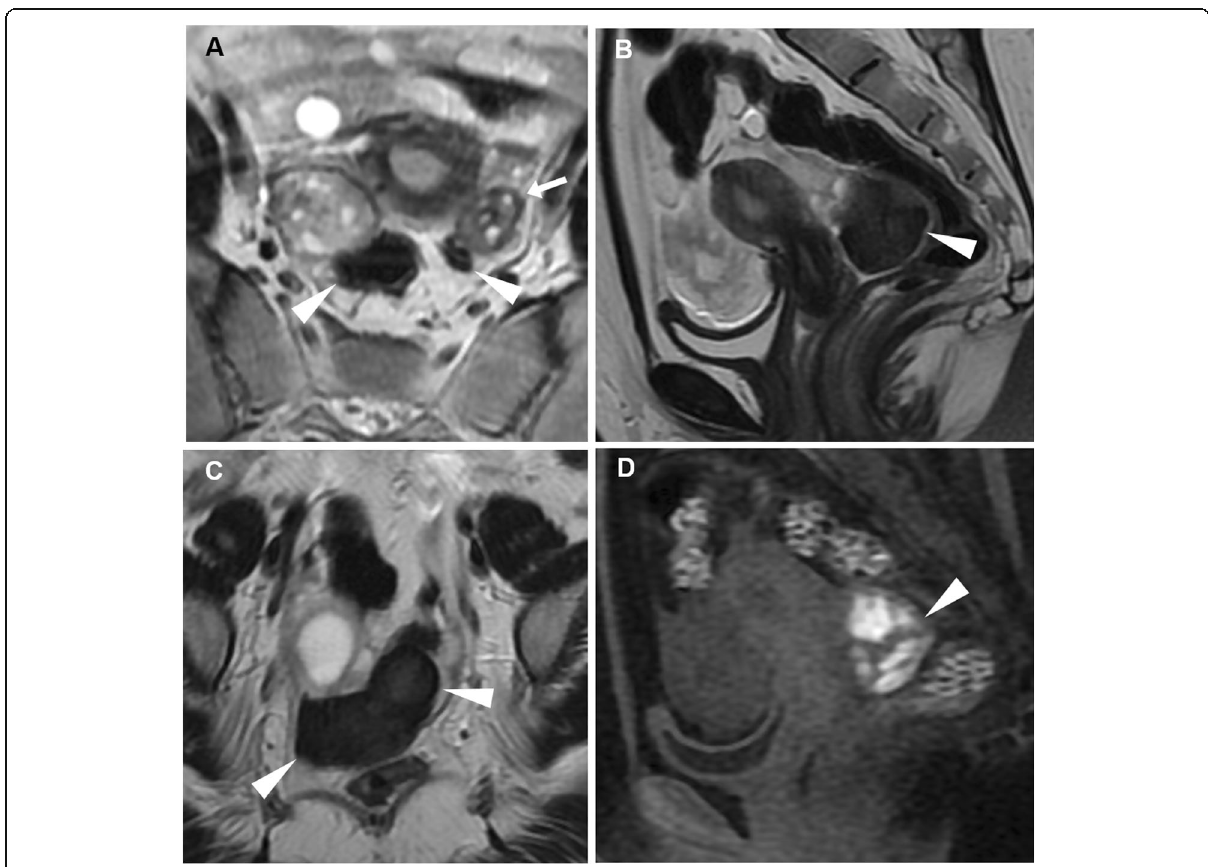
Fig. 15 Ruptured corpus luteum in a 20-year-old woman with pelvic pain and fever over the previous 2 days. Oblique-axial ( a ), sagittal ( b ) and oblique-coronal ( c ) T2-weighted and sagittal precontrast fat-suppressed T1-weighted ( d ) images show a haemorrhagic collection (arrowheads), T2-hypointense and T1-hyperintense, in the pouch of Douglas, contiguous to the left ovary (arrow in a ). The latter represents the source of bleeding, although the corpus luteum is no longer recognizable